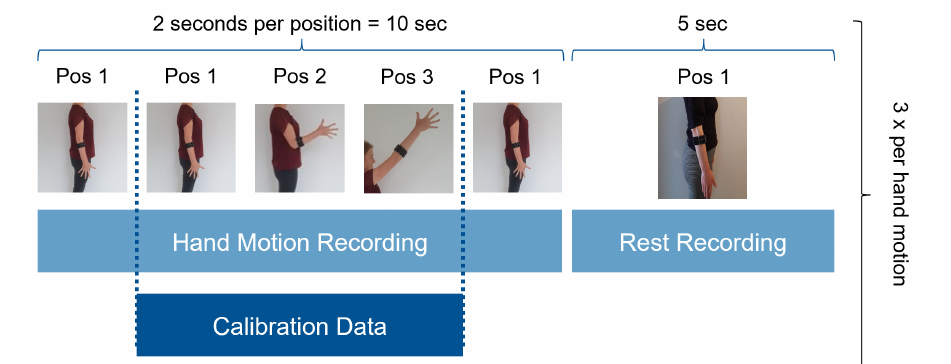
Figure 10. Calibration phase procedure. The subject was instructed to conduct a hand motion continuously for 10 s, followed by 5 s of rest. Within the 10 s, limb position commands appeared every 2 s. The first and last 20% of the hand motion recording were cut to account for reaction delay. This sequence was repeated three times for each of the six hand